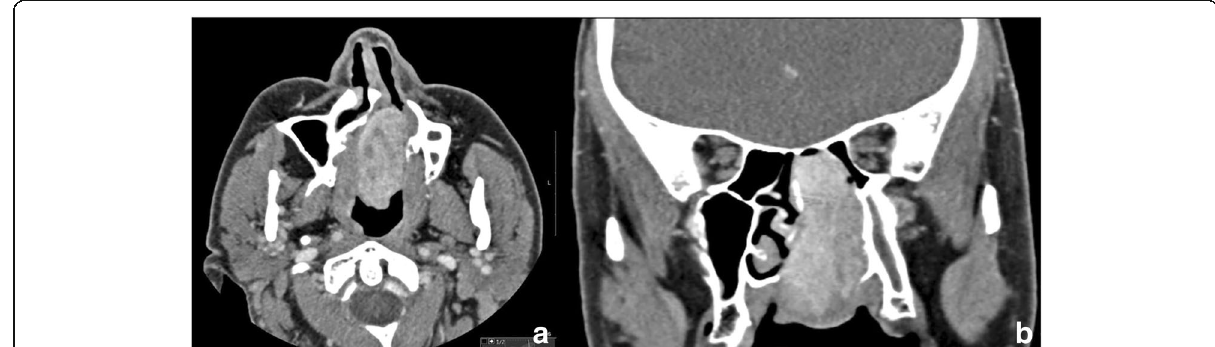
Fig. 6 SFT of the left nasal cavity. The left nasal cavity is filled with a solid, lobular, enhancing